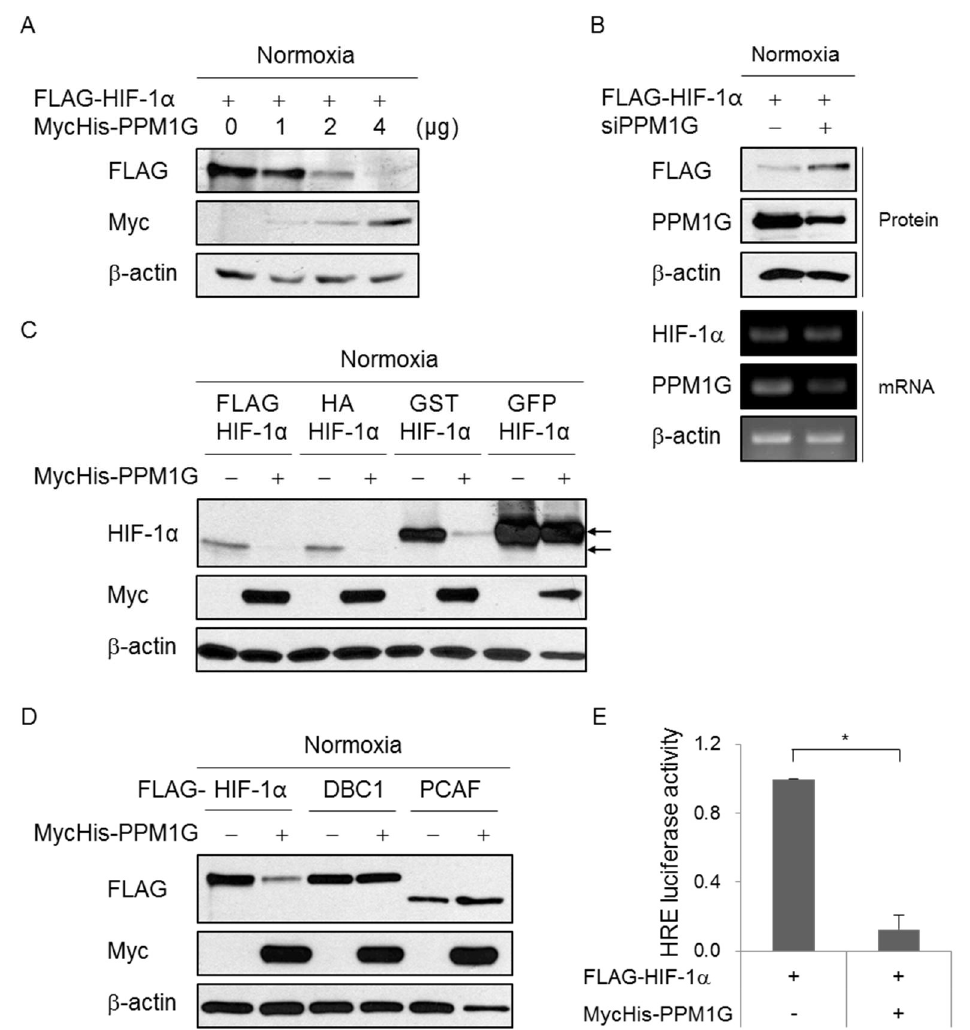
Figure 1. Protein phosphatase 1 gamma (PPM1G) downregulates hypoxia-inducible factor (HIF)-1α expression under normoxic conditions. HEK293T cells were transfected with MycHis-Empty (−) or MycHis-PPM1G (+) ( A ), control siRNA (−) or PPM1G-targeting siRNA (siPPM1G) ( B ), vectors harboring HIF-1α fused with various tags ( C ), and vectors encoding other proteins ( D ). Cells were then cultured under normoxic conditions. Expression of each protein was determined by Western blotting and PPM1G knockdown was confirmed by RT-PCR. ( A ) FLAG-HIF-1α expression in cells transfected with various amounts of the PPM1G vector; ( B ) Expressions of FLAG-HIF-1α protein and PPM1G mRNA in PPM1G-depleted cells; ( C ) FLAG-HIF-1α, HA-HIF-1α, GST-HIF-1α, and protein and PPM1G mRNA in PPM1G-depleted cells; ( C ) FLAG-HIF-1 α , HA-HIF-1 α , GST-HIF-1 α GFP-HIF-1α expression in PPM1G-overexpressing cells. Arrows indicate tagged HIF-1α; ( D ) FLAG-HIF-1α, FLAG-DBC1, and FLAG-PCAF expression in PPM1G-overexpressing cells; ( E ) HEK293T cells were co-transfected with the PGK1-HRE-Luc reporter, a β-galactosidase-encoding plasmid and either MycHis-Empty (−) or MycHis-PPM1G (+) in the presence of HIF-1α overexpression. Relative luciferase activity was calculated after normalization of transfection efficiency according to the β-galactosidase activity. * p < 0.05; significantly different from only FLAG-HIF-1α-transfected cells.